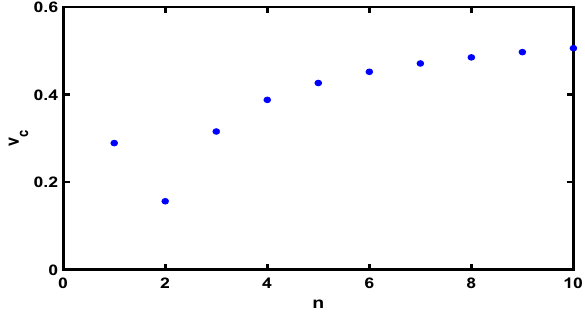
Fig. 7 Kink-antikink collision. Critical velocity as a function of n